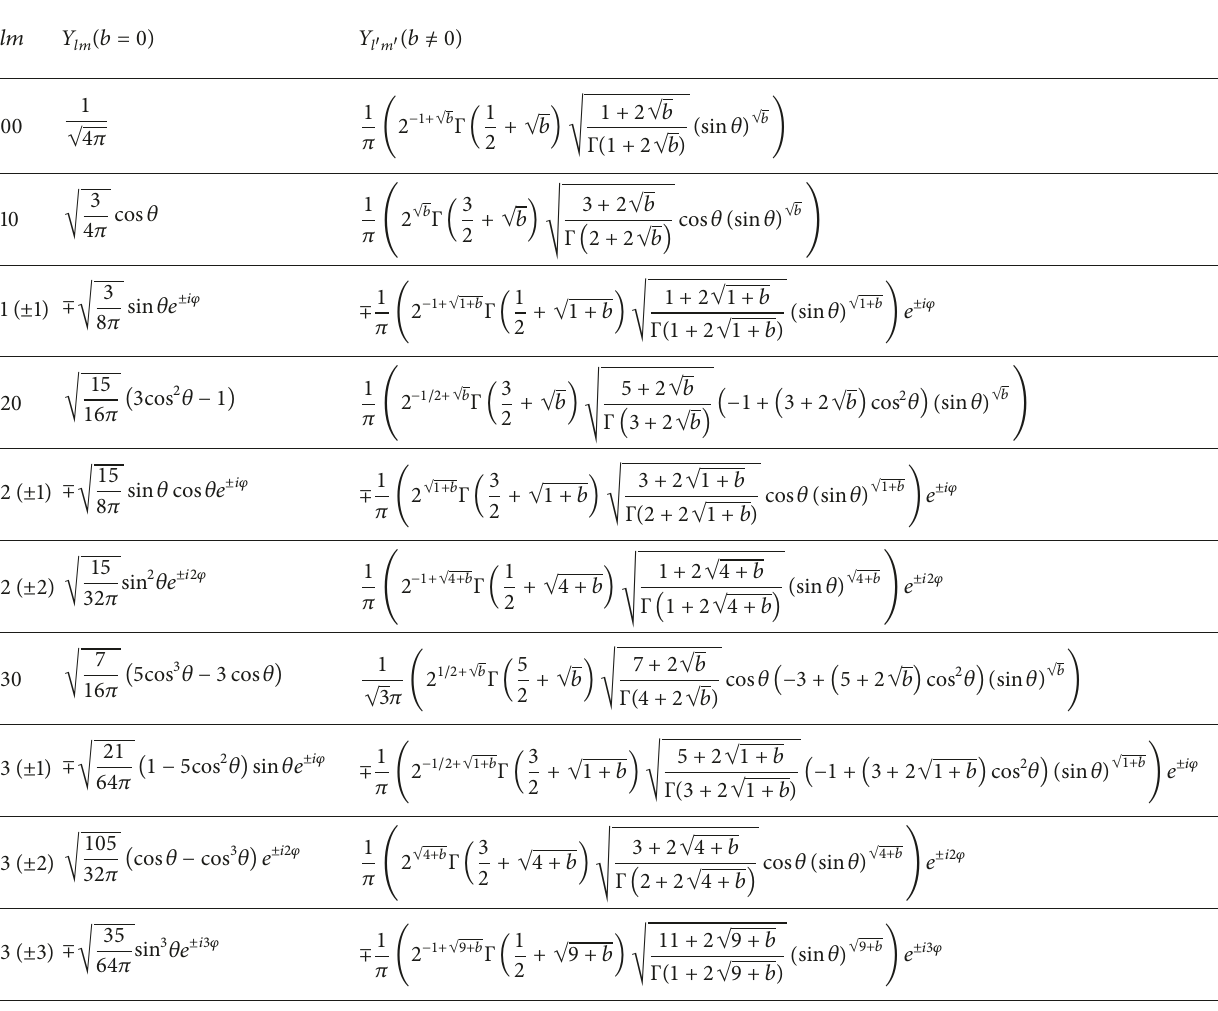
Table 1: Analytical expressions of 𝑌 𝑙 󸀠 𝑚 󸀠 (𝜃,𝜑) for special cases 𝑏 = 0 and 𝑏 ̸= 0